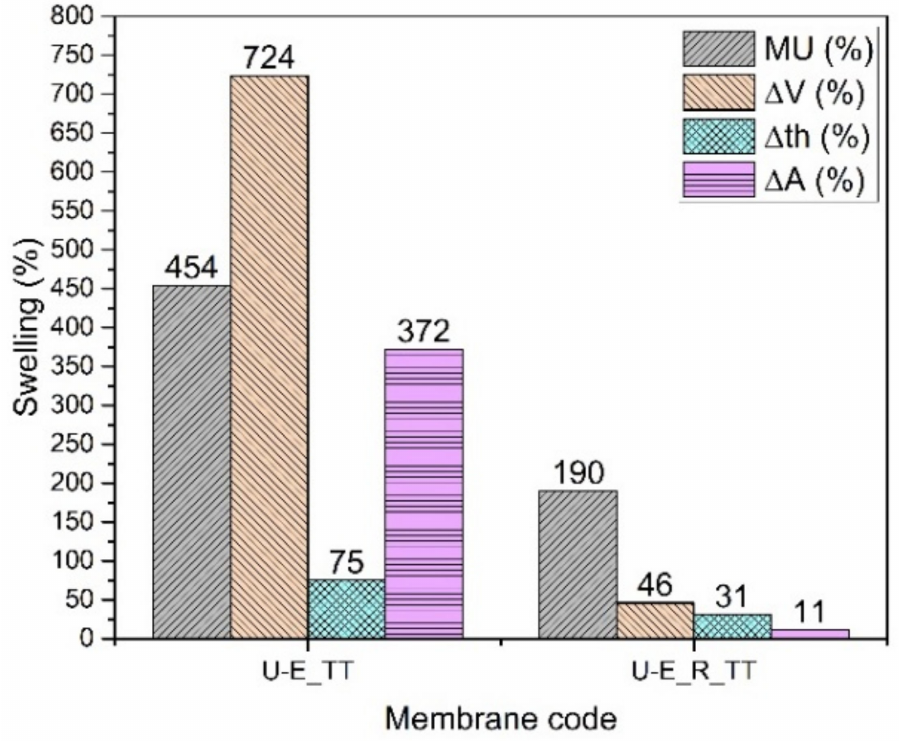
Figure 6. Swelling data of U-E membranes. Table 4. Fully hydrated thickness, Young’s modulus, ionic conductivity and dry density U-E mem- branes. * Measurement carried out in anhydrous conditions due to the solubility of the polymer. Membrane Code U-E